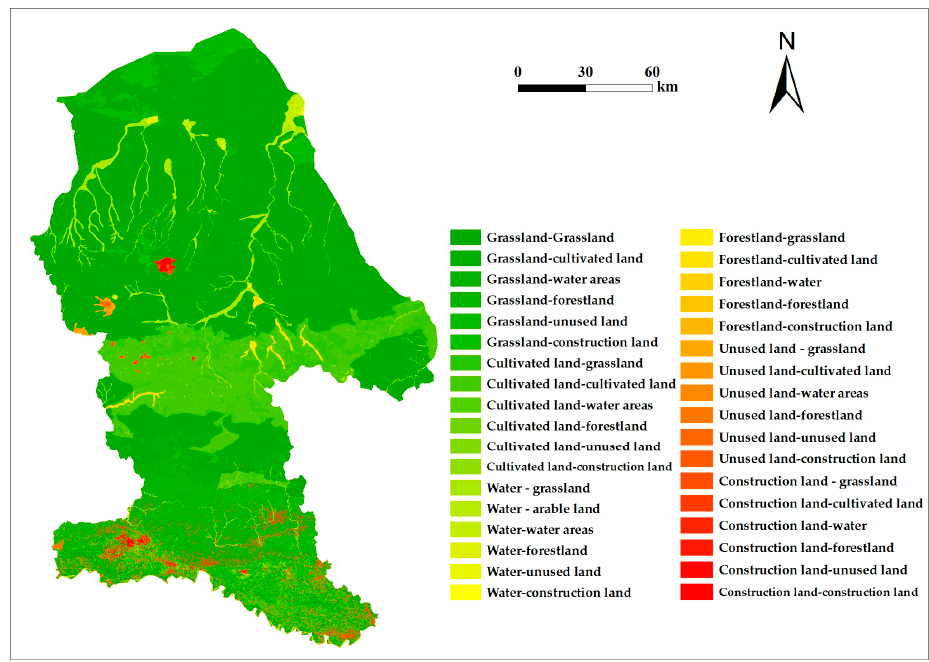
Figure 9. Land ‐ use transfer matrix for Baotou City during the 1990–2020 period. Figure 9. Land-use transfer matrix for Baotou City during the 1990–2020